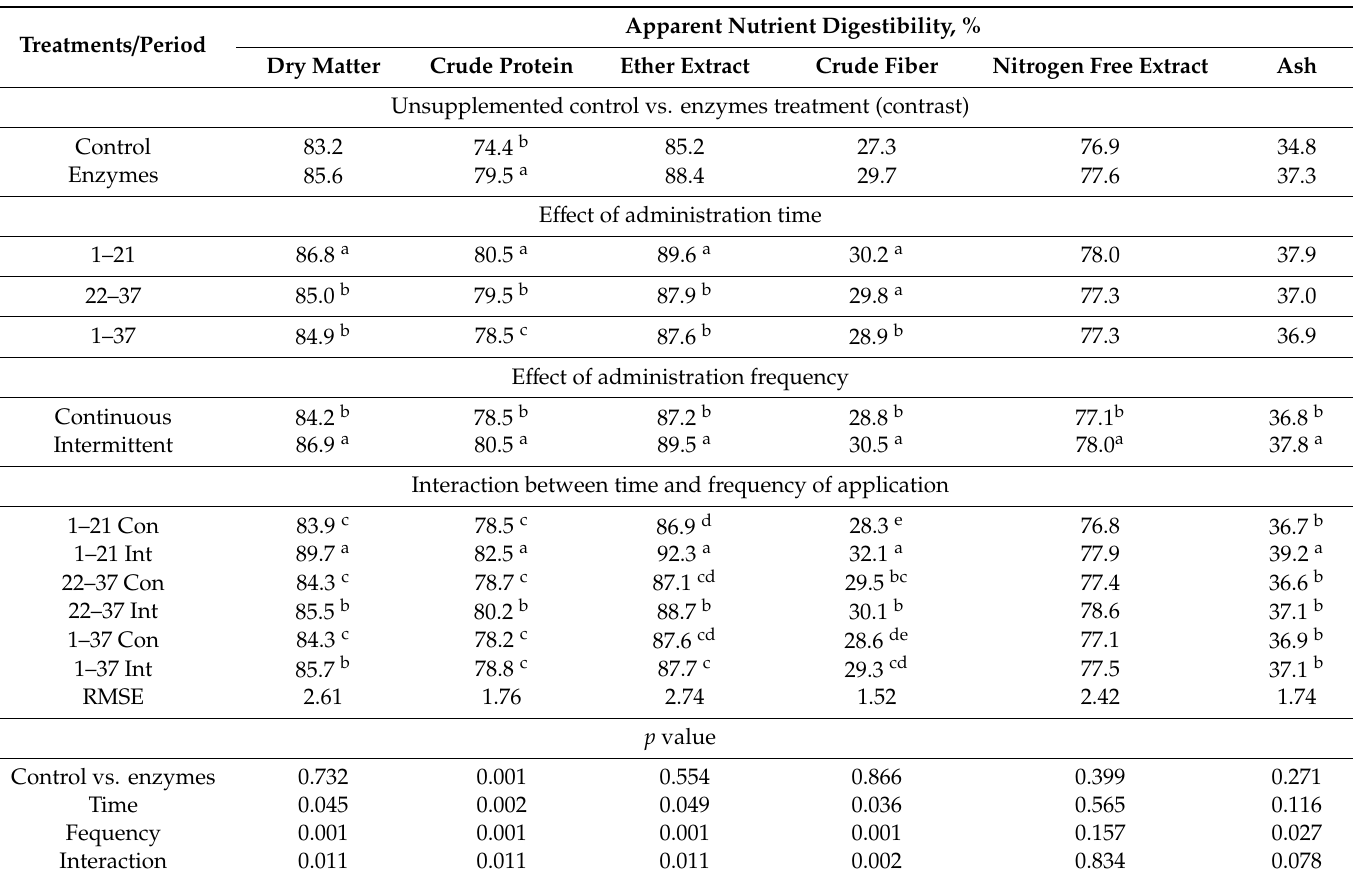
Table 3. E ff ect of multienzymes supplemented in water continuously or intermittently on apparent nutrient digestibility of broiler chicks. Treatments / Period